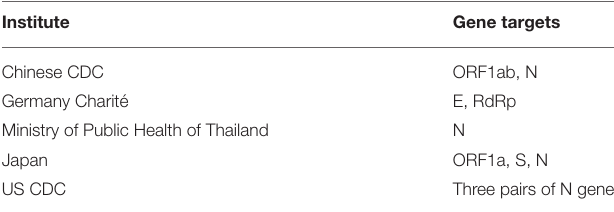
TABLE 1 | Recommendations about the detecting genes for